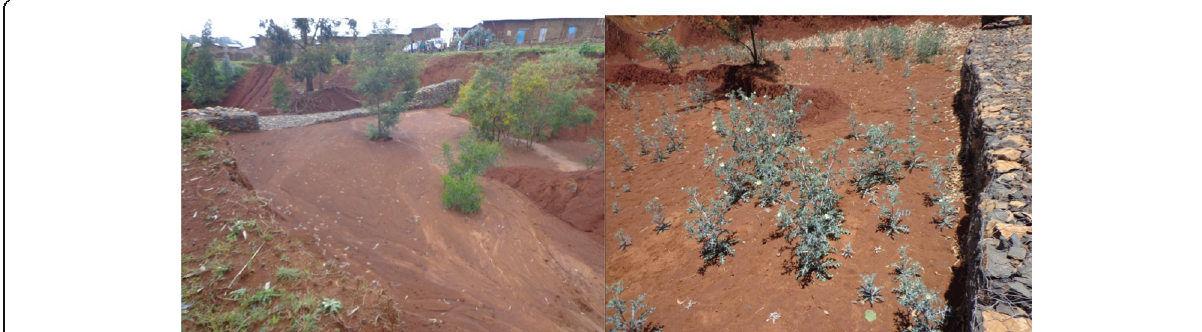
Fig. 2 Example SSD pictures constructed to sequester sediment and SOC two years old (left, Segno Gebeya watershed) and five years old (right, Woybila watershed), in the northwest highlands of